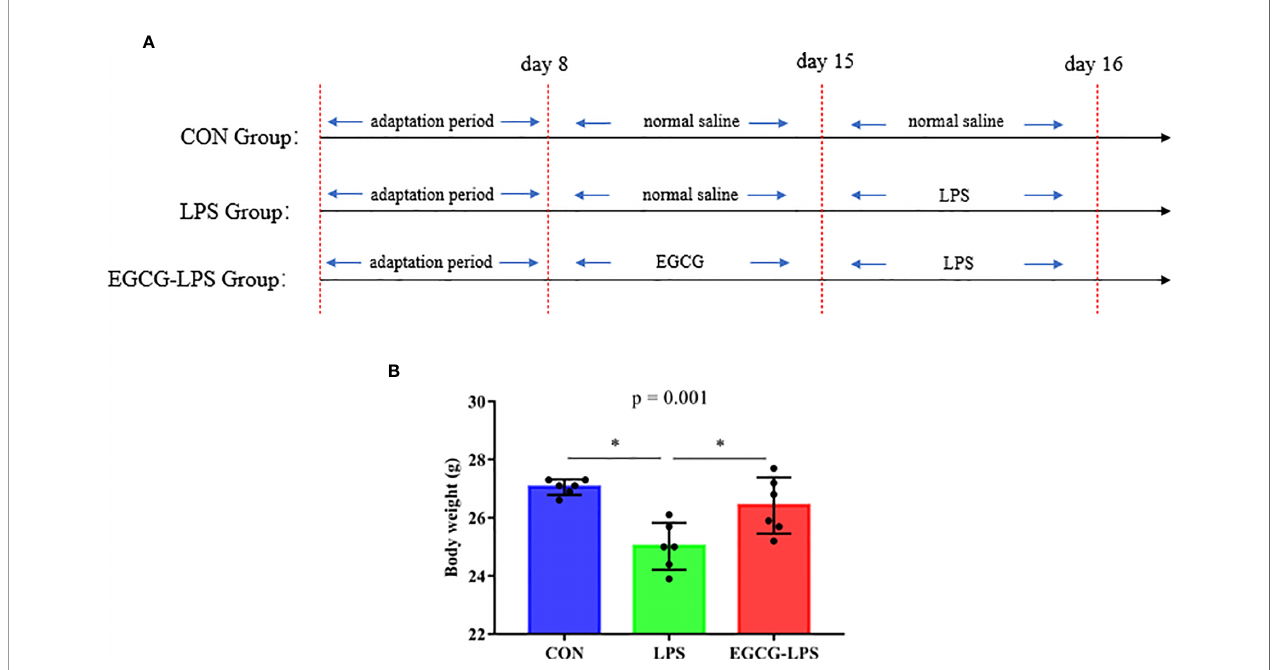
FIGURE 1 | The protective effects of intragastric administration of EGCG on body weight. (A) the experimental process; (B) body weight. Data are mean ± SD (n = 6) and analyzed by one-way ANOVA. “ * ” means that the horizontal line connects the p -value of the data between the two groups <0.05, and the “ P ” value in the fi gure represents the accurate value of p between the three groups of data, and some of the p values between the three groups are too small to be expressed as p